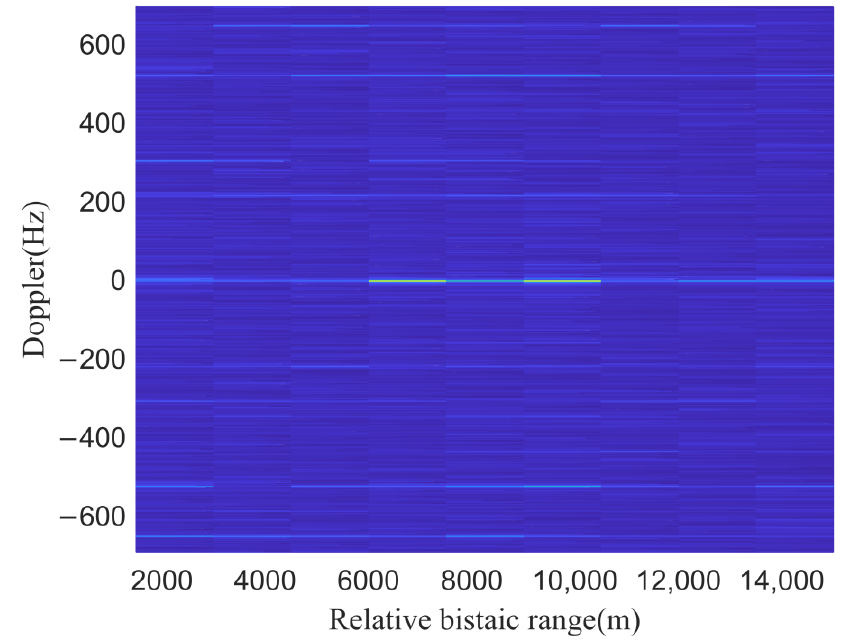
Figure 17. RDCC after eliminating BS-IoO interference.